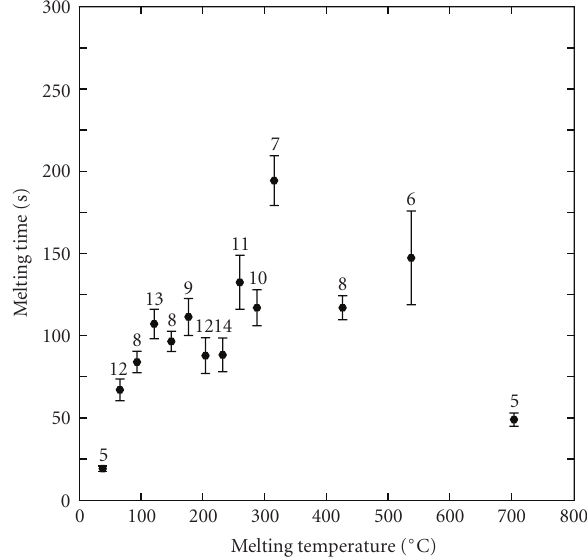
Figure 6: Melting times (mean ± S.E.) of temperature-sensitive paints (Tempilaq, Tempil Division, Big Three Industries, Inc.) on glass petri dishes. The number above each symbol represents the number of melting trials conducted for that paint. In each trial a petri dish was placed in a mu ffl e furnace set at the melting temperature of the paint on the dish, and melting time was